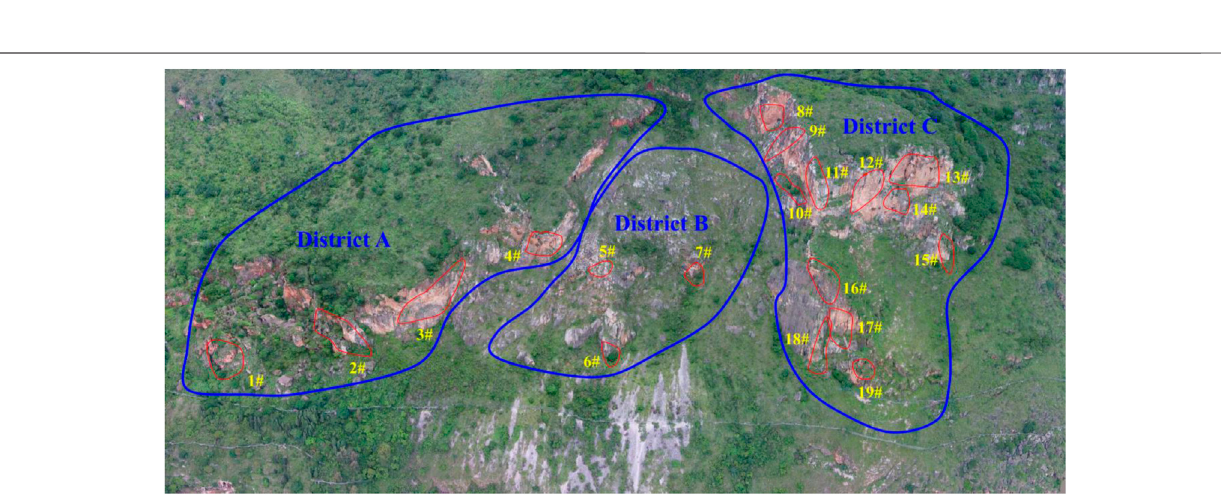
Frontiers in Earth Science |